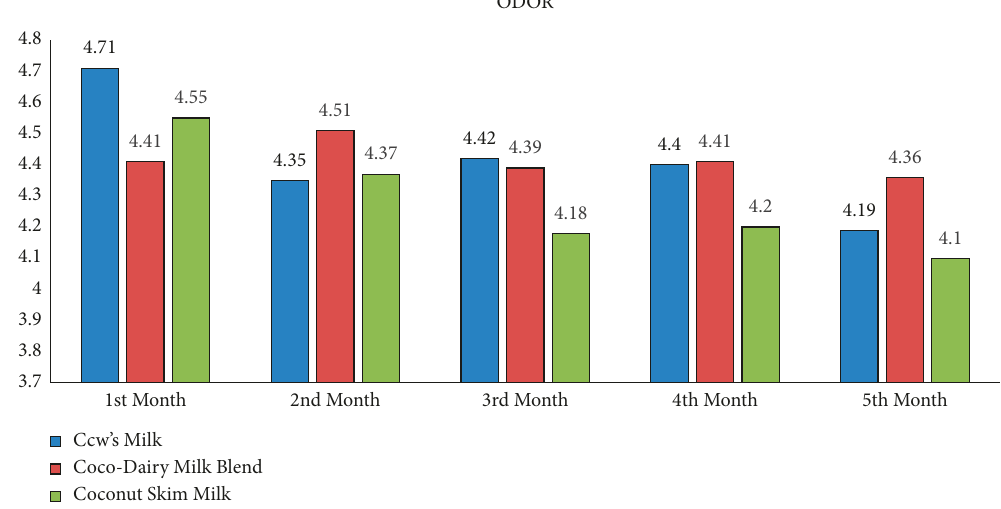
Figure 2: Average acceptability scores of milk products according to odor by months.